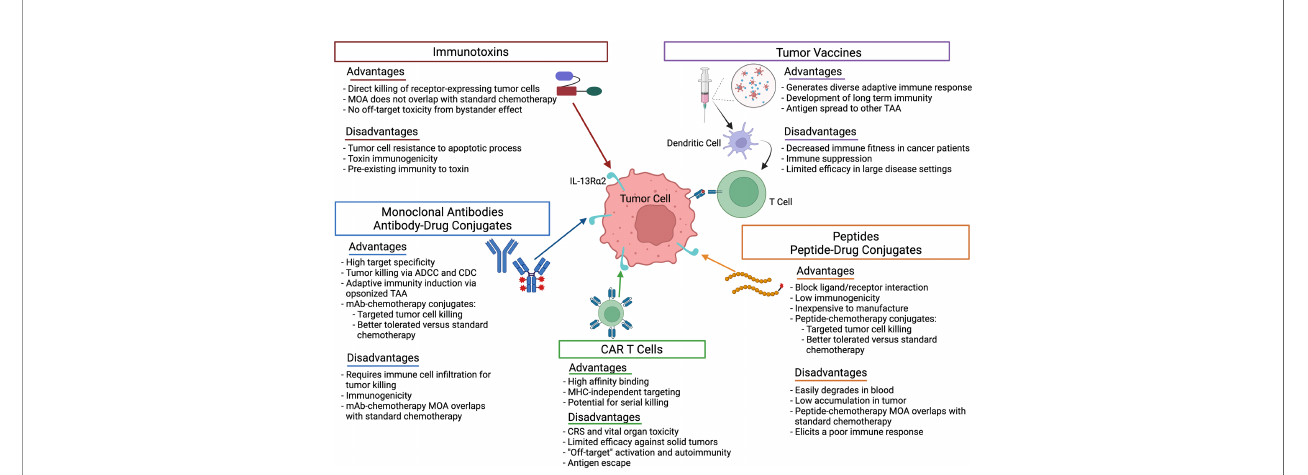
FIGURE 1 | Advantages and disadvantages of the therapeutic strategies used to target IL-13R a 2 in cancer. ADCC, antibody-dependent cellular cytotoxicity; CDC, complement-dependent cytotoxicity; CRS, cytokine release syndrome; mAb, monoclonal antibody; MHC, major histocompatability complex; MOA, mechanism of action; TAA, tumor associated